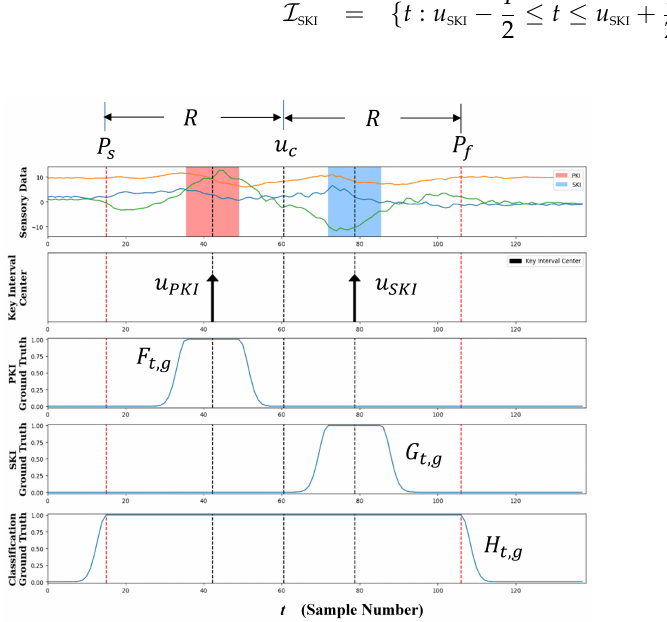
Figure 3. An example of labelling process for a training sequence S containing only a single gesture. The P f and P s of the top graph are the locations of the start and final samples of the gesture, respec- tively. The u c of the top graph is the centroid of the gesture. The second graph marks the locations of u and u as black arrows. The third, fourth, and the bottom graphs reveal the Gaussian-like PKI SKI ground truth of the gesture for PKI score, SKI score, and classification score,